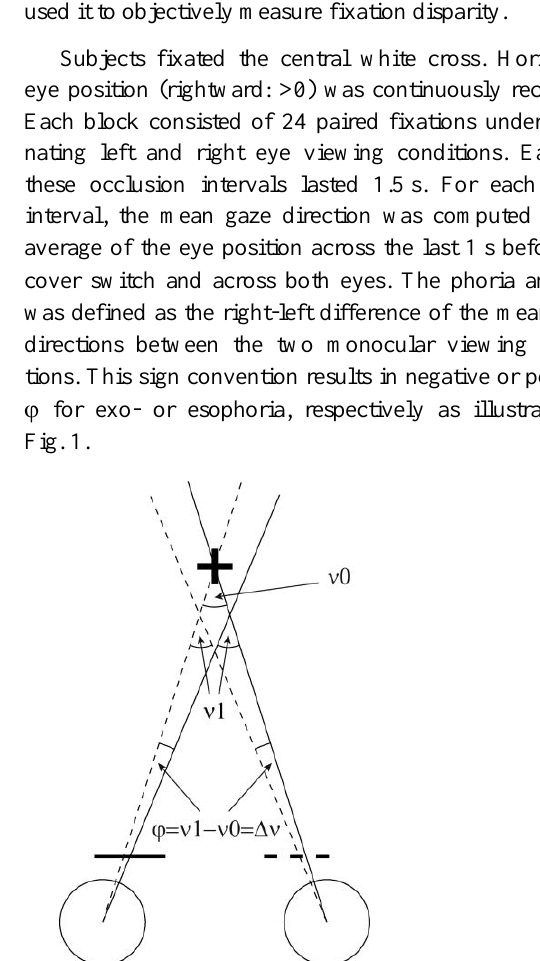
Figure 1: Illustration of the alternating cover test in esophoria. Solid/dashed: gaze lines during right-eye/left-eye viewing conditions. Gaze directions during right-eye viewing are more rightward than under left-eye viewing conditions. The right-left difference  (positive in this case) equals the convergent (esophoric) vergence error  , i.e. the difference between the actual vergence angle (  1) and the required vergence angle 